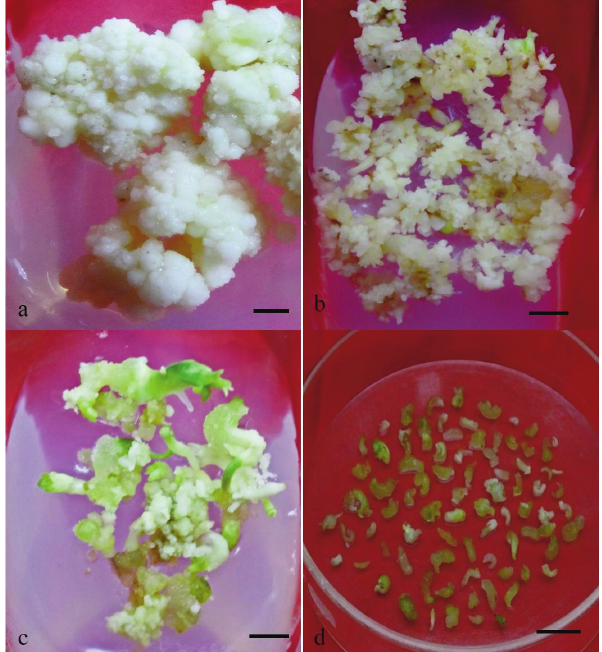
Fig. 1 - Somatic embryo formation in Coriandrum sativum (RS). a) Globular embryos at induction stage; b) Somatic embryos at proliferation stage; c and d) Somatic embryos at maturation stage (scale bar, a-2 mm; b-c= 3 mm; d=1